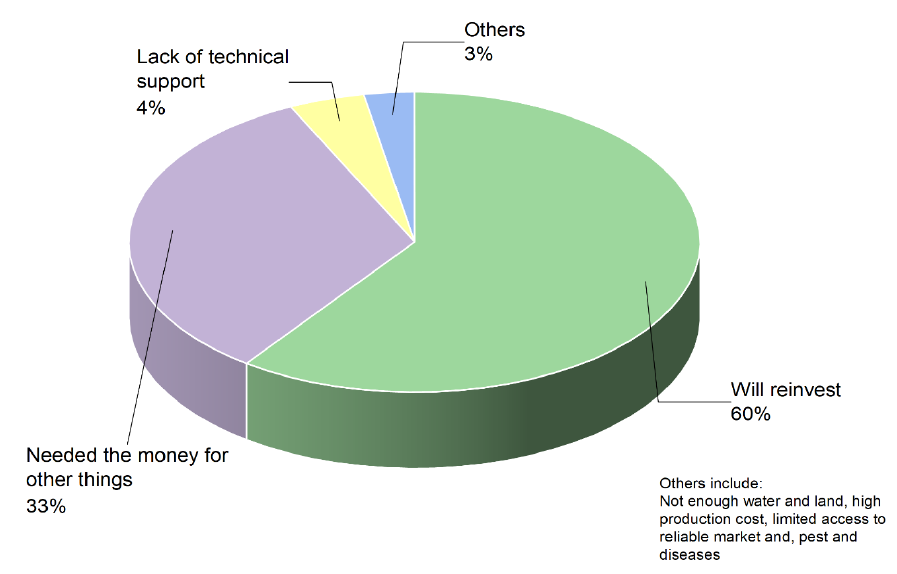
Figure 9. A comparison of MI farmers who reinvested in the vegetable kits and most common reasons for not reinvesting in vegetable kits.